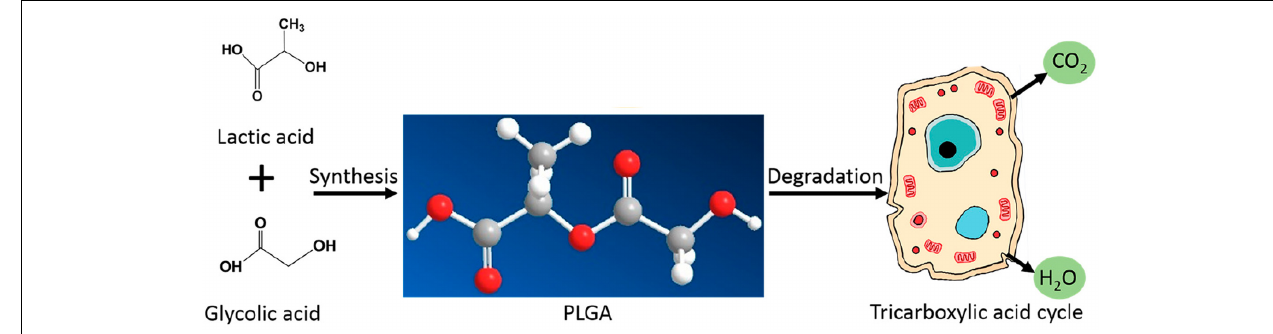
FIGURE 1 | The synthesis and physiological breakdown of PLGA, adapted from Sun et al. (2017).